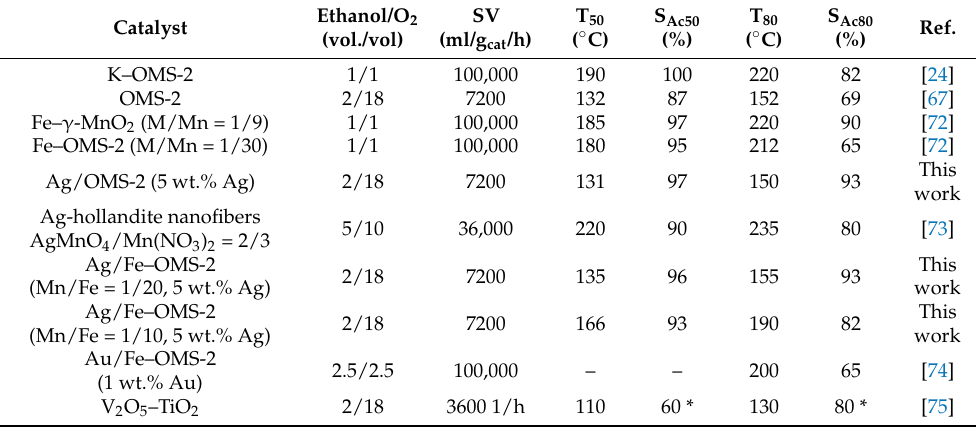
Table 5. The comparison of catalytic properties of different catalysts in the ethanol oxidation.